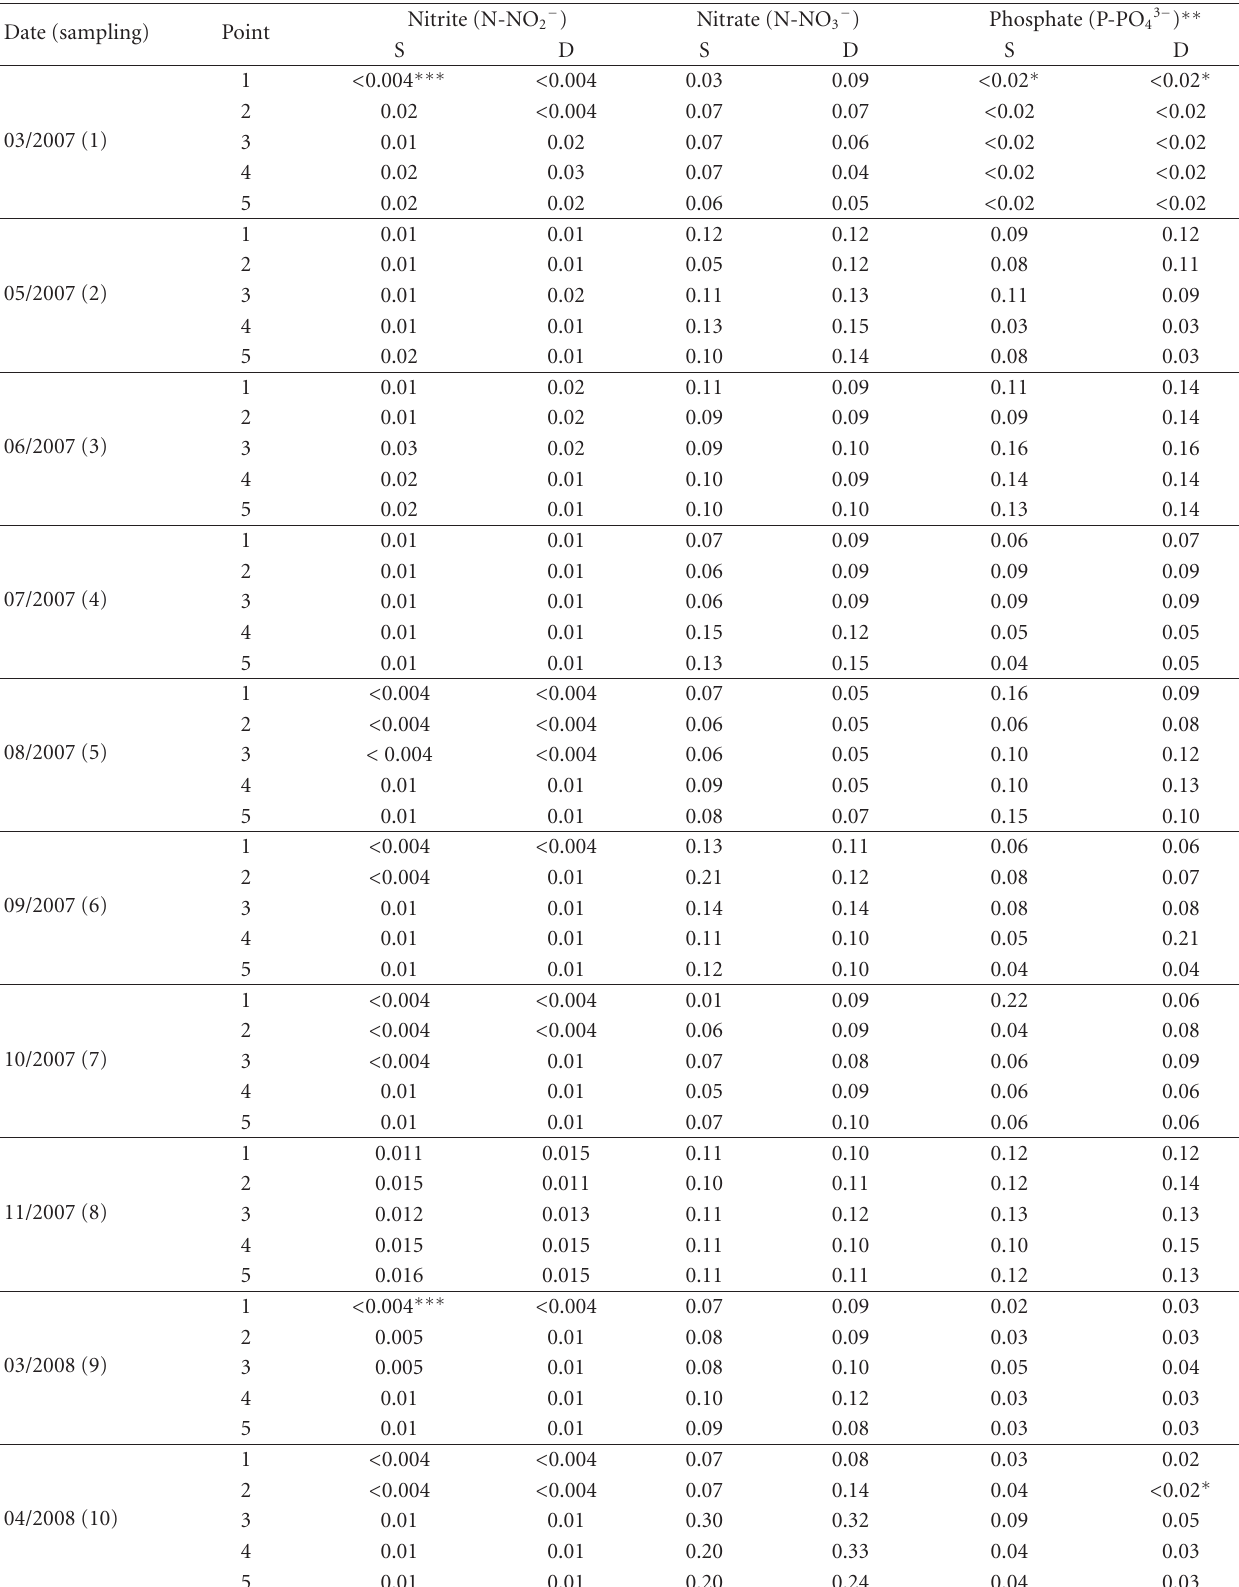
Table 3: Concentrations (mgL − 1 ) of nitrite (N-NO 2 − ), nitrate (N-NO 3 − ), and soluble phosphate (P-PO 43 − ) in water samples collected from the Jacu´ıpe River’s estuary, n = 3 ∗